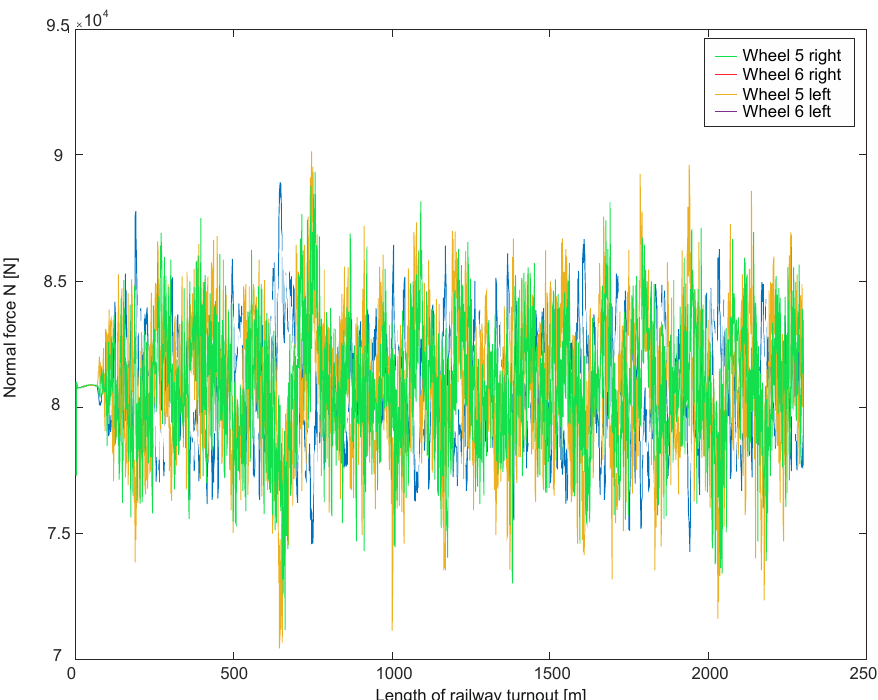
Figure 20 . Normal force at 150 km/h on a straight track without a turnout .